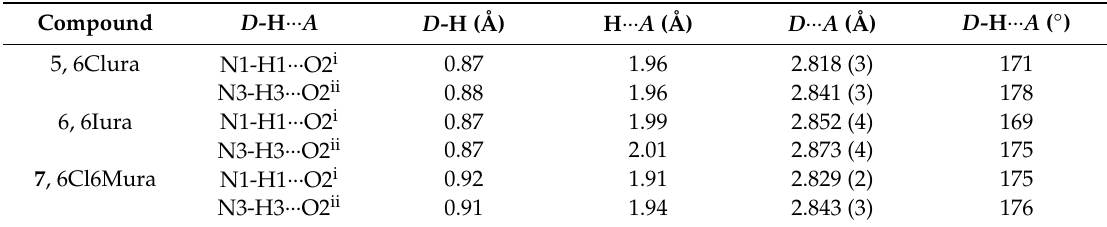
Table 3. Hydrogen-bond geometries for compounds 5–7.